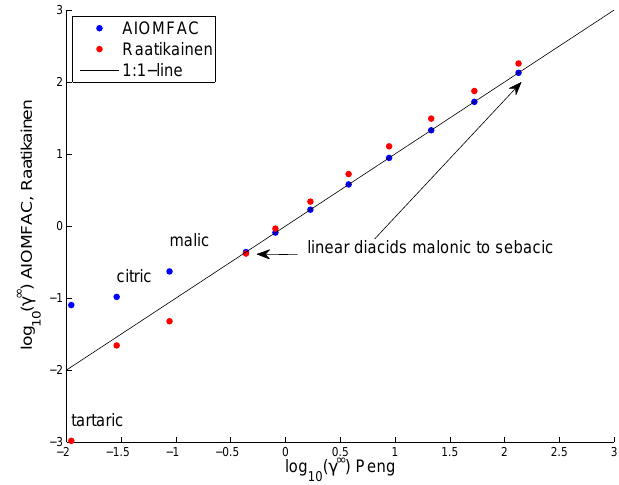
Fig. 1. Comparing log 10 γ ∞ at 298.15K as estimated by different γ ∞ at 298.15 K as estimated by different methods: AIOMFAC Fig. 1 : Comparing log methods: AIOMFAC and UNIFAC-Raatikainen vs. UNIFAC-Peng. 10 and UNIFAC-Raatikainen, vs. For the linear diacids, AIOMFAC and UNIFAC-Peng are identical.